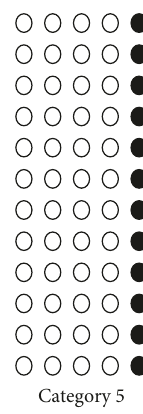
Figure 2: Memory standard model of DHNN evaluation model.